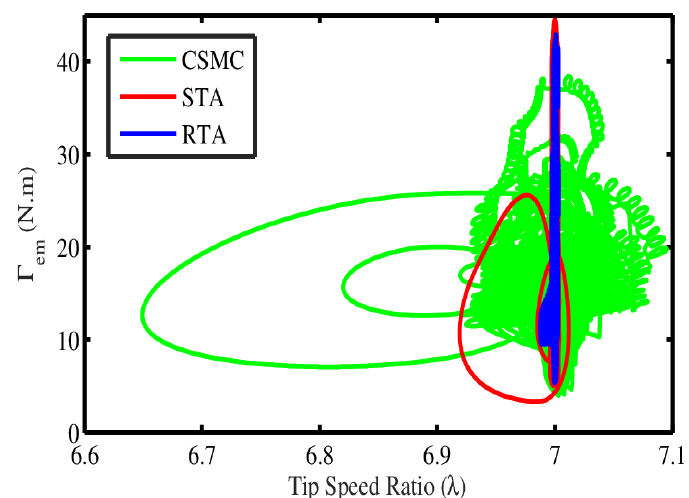
Figure 9. Turbine power coefficients.